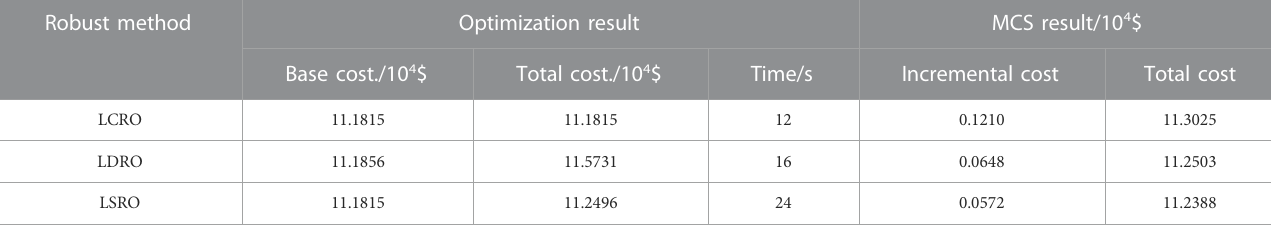
TABLE 3 Comparison of robust methods in the IEEE 39-node system. Robust